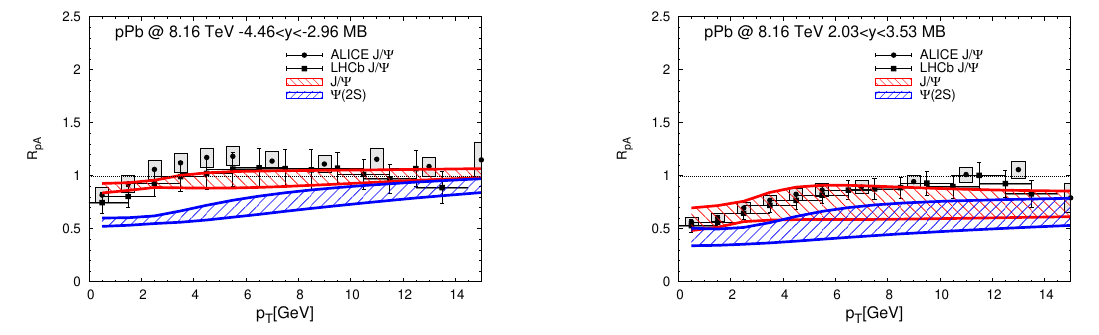
Figure 7 . Same as (cid:12)gure 6 but for 8.16 TeV p -Pb collisions with ALICE and LHCb data [20, 21] at 8.16